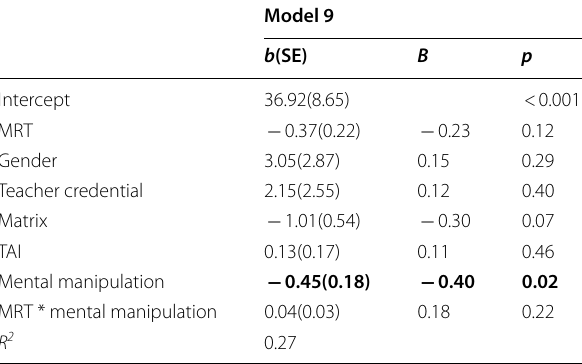
B are standardized betas. Numbers in parentheses are standard errors. “Matrix” denotes the ICAR Matrix Reasoning assessment. “TAI” denotes Trait Anxiety Inventory. ““Mental Manipulation” denotes the Mental Manipulation subscale of the Spatial Anxiety Scale. The outcome variable for Model 9 is teachers’